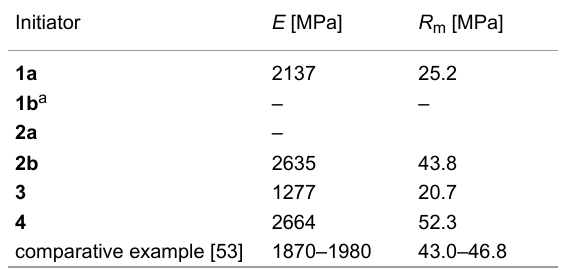
Table 2: Tensile test values for shoulder test bars initiated with com- plexes 1 – 4